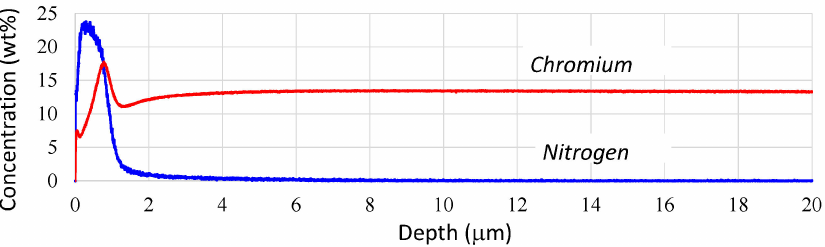
Figure 3. Distribution of the nitrogen and chromium in the nitrided sample (obtained by GDOES).